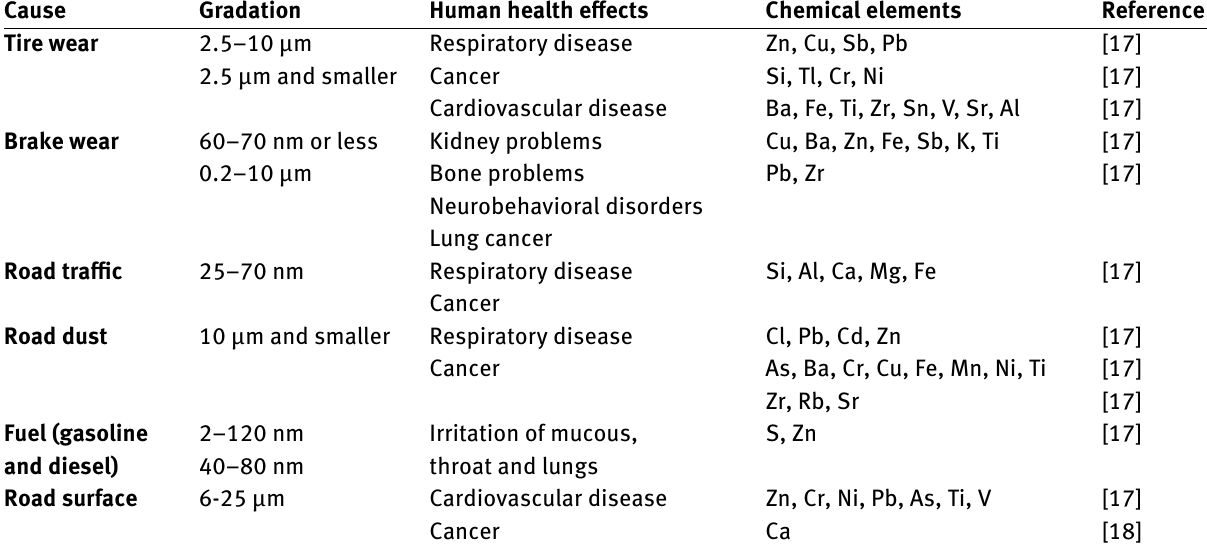
Table 2: Sensors that can be used to detect chemical elements